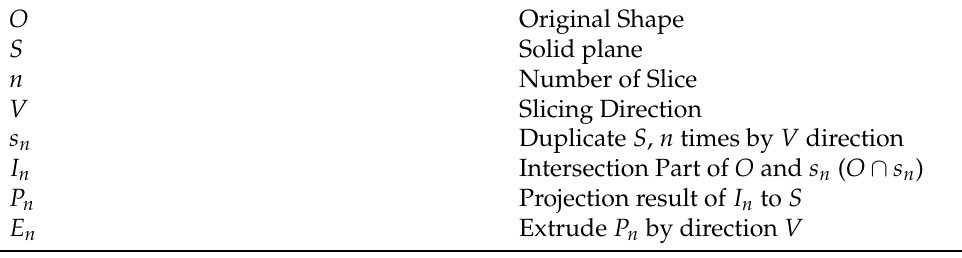
Algorithm 1: Squash partial section of manifold shape Data: O , S , n , V Result: Squashed partial section of manifold